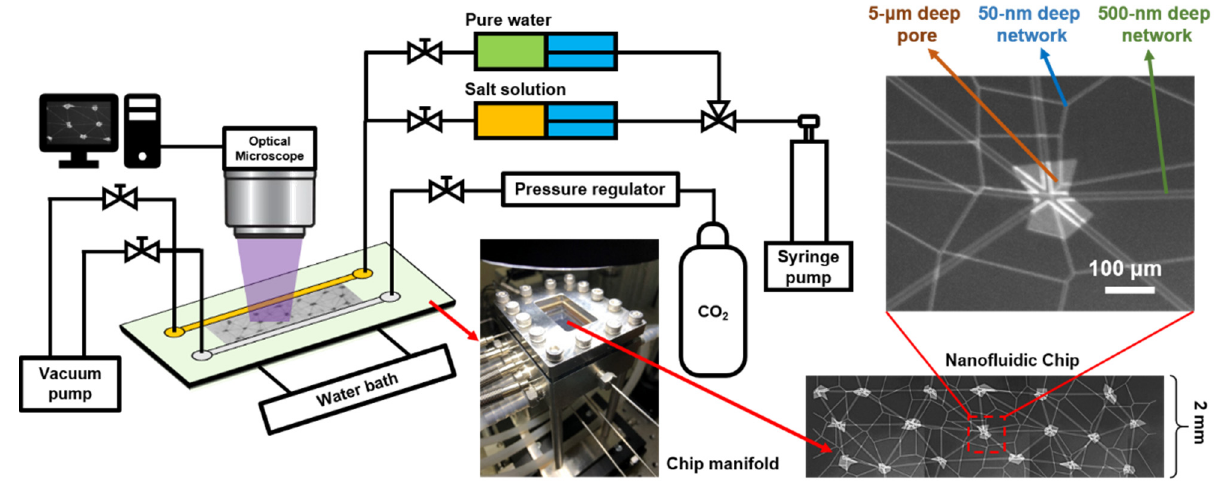
Figure 1. Schematic and photos of the experimental setup and the nanofluidic chip.